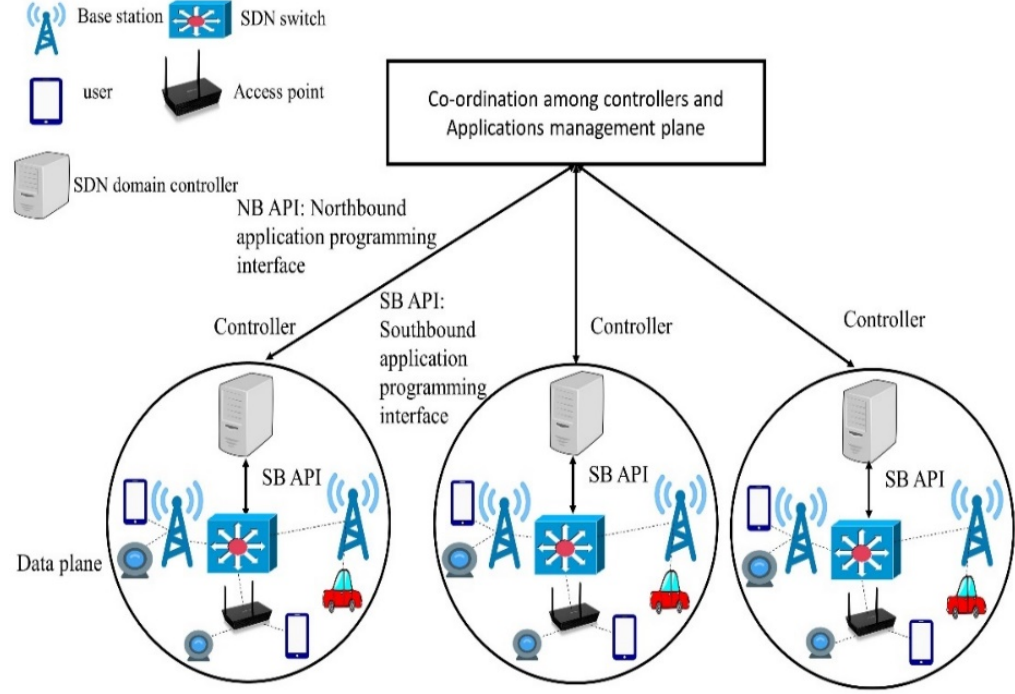
Figure 2. SD-IoT architecture.